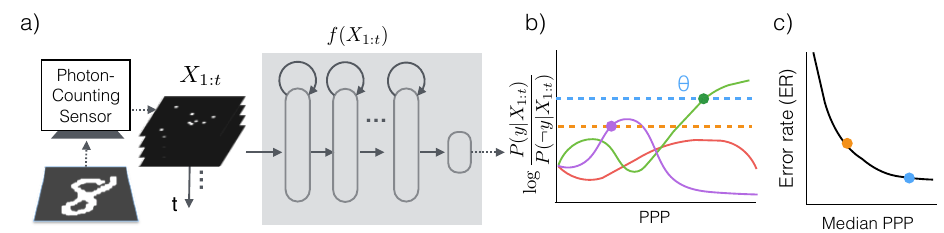
Figure 2. Low-light classification. ( a ) A sensor produces a stream of photon counts X 1: t , which is fed into a recurrent neural network to compute class conditional likelihood f ( X 1: t ) with three classes. Based on f ( X 1: t ) , SPRT compares the class with the highest log likelihood ratio to a threshold θ . Two threshold options (dashed lines) corresponds to different decisions at different times (solid dots). ( c ) The threshold allows the system to traverse the error rate (ER) versus PPP curve to find the optimal operating point to minimize the cost function (Equation (2)). We use PPP instead of the exposure time T to measure speed as the former is more closely related to the information content in the photon stream. We use the median PPP instead of the mean because PPP follows a heavy-tailed distribution (Figure 3c) and median is more stable than the mean.